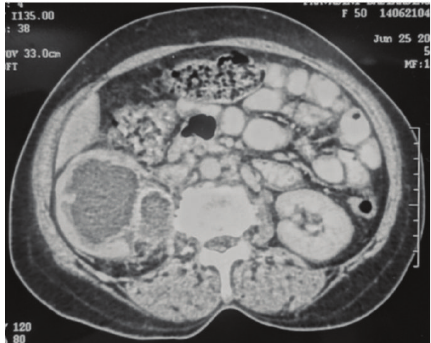
Figure 3: Normal glomeruli adjacent to focus of squamous epithe- lial carcinoma.